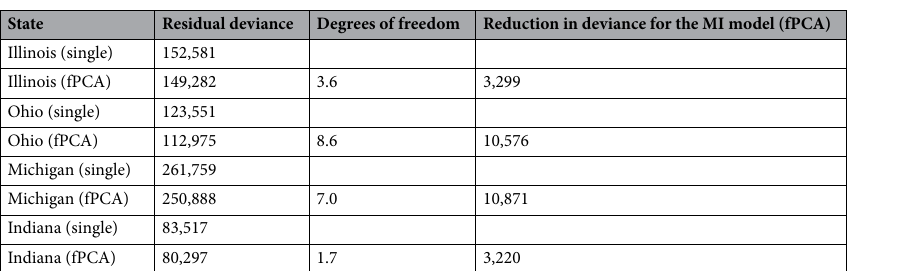
population-level movement. While we have used mobility data from Safegraph, several other mobility datasets have have been studied with regards to COVID-19. Zachreson et al. used data from Facebook to determine the validity of aggregate human mobility data for COVID transmission patterns 60 . Aggregate mobility data is avail- able through the Facebook Data For Good Program, which uses the mobile apps’ location service records of the users GPS locations. To be captured in this database, participants must be a member of Facebook and enable location services. To prevent users from being identified, Facebook removes users who do not meet a certain